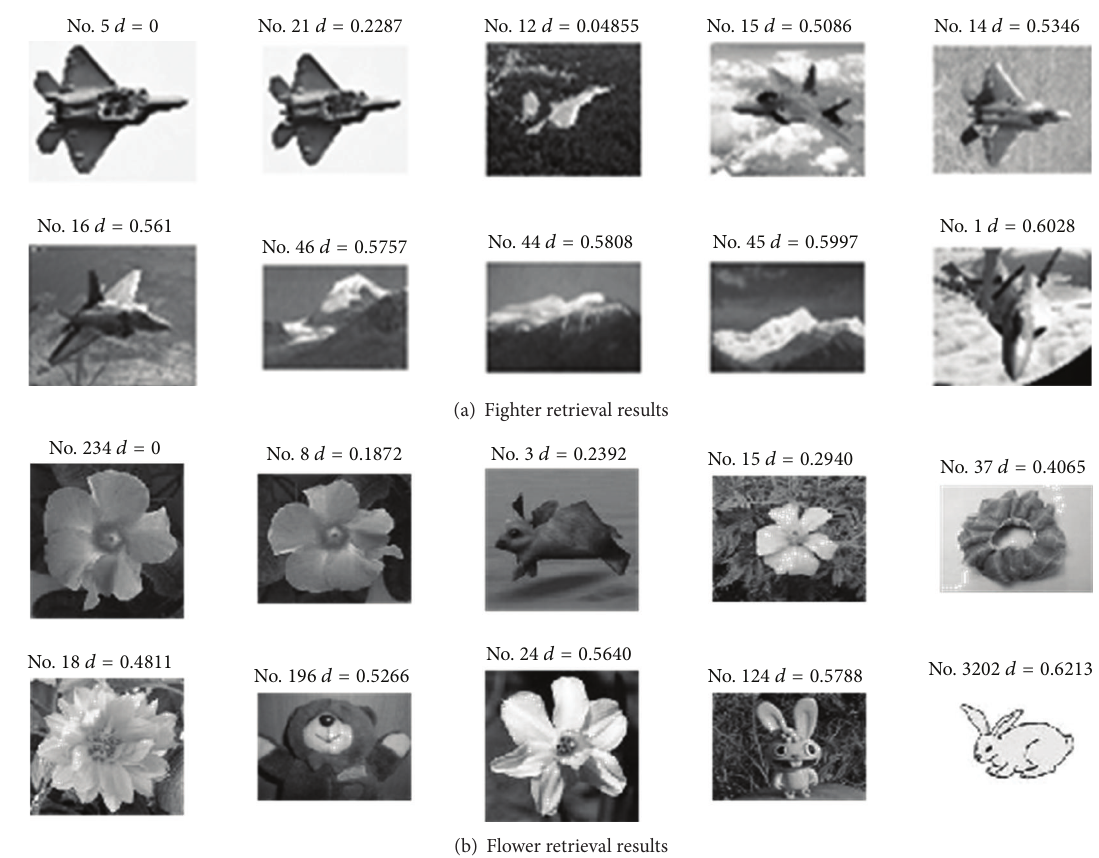
Figure 9: Retrieval results for